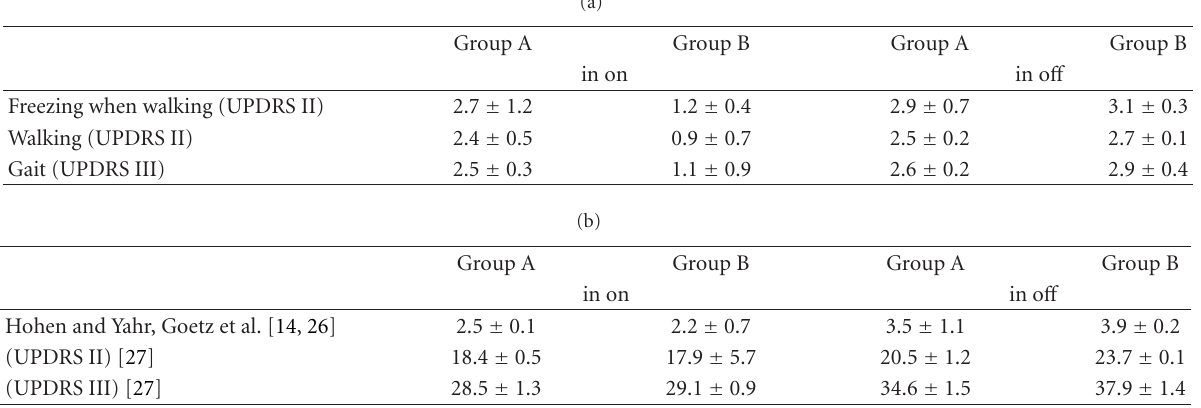
Table 1: (a) Specific scores of the two groups, (b) specific scores of the two